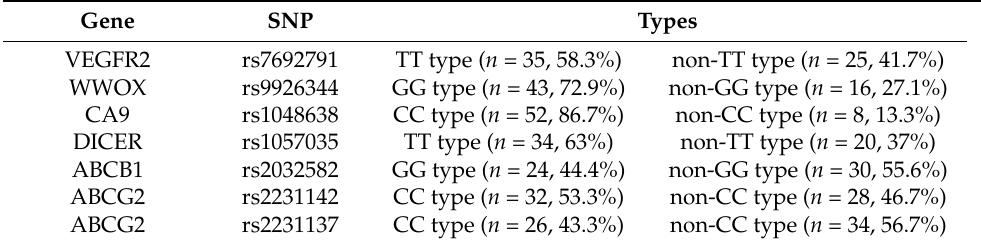
Table 4. Frequency distributions of VEGFR2, WWOX, CA9, DICER, ABCB1, ABCG2, and ABCG2 polymorphisms in patients with